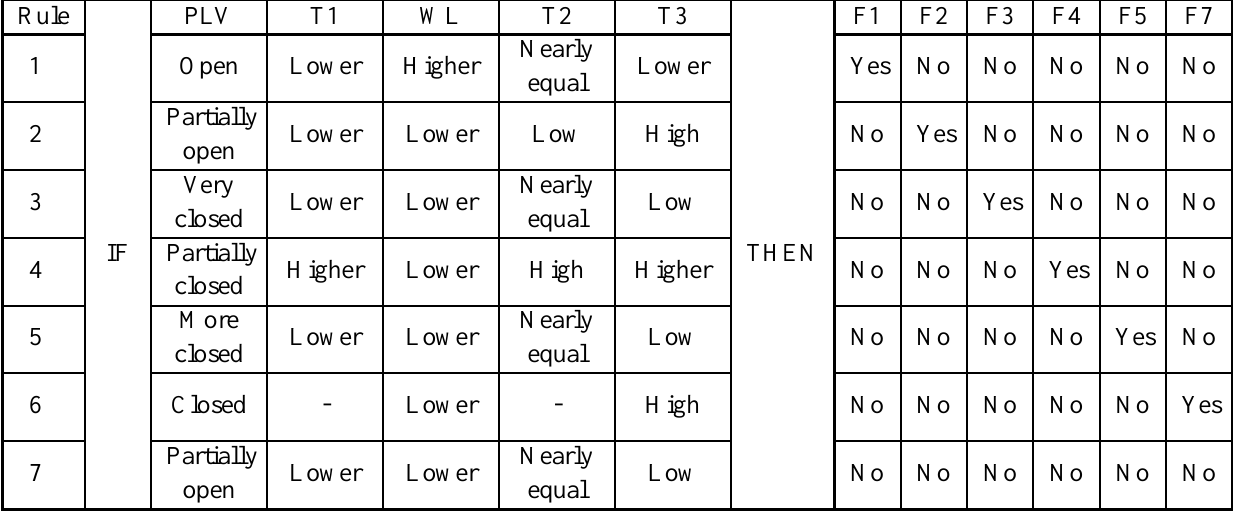
Table 2. The Table of rules of the